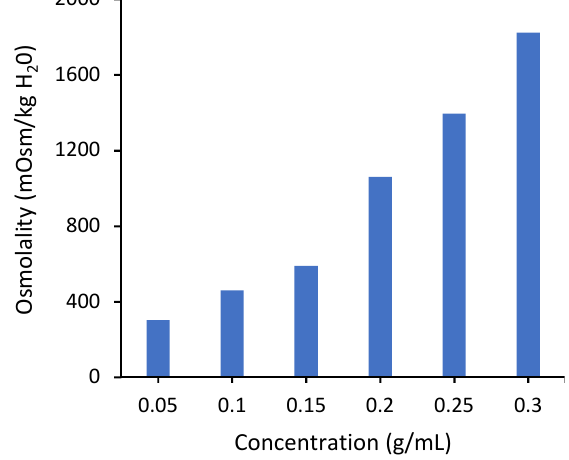
Figure 4. Osmotic pressure of PAA-Na measured by osmometry with the OsmoPRO Multi-Sample Micro-Osmometer from Advanced Instruments. The instrument was unable to determine the osmo- lality at concentrations higher than 0.3 g/mL due to a higher viscosity.